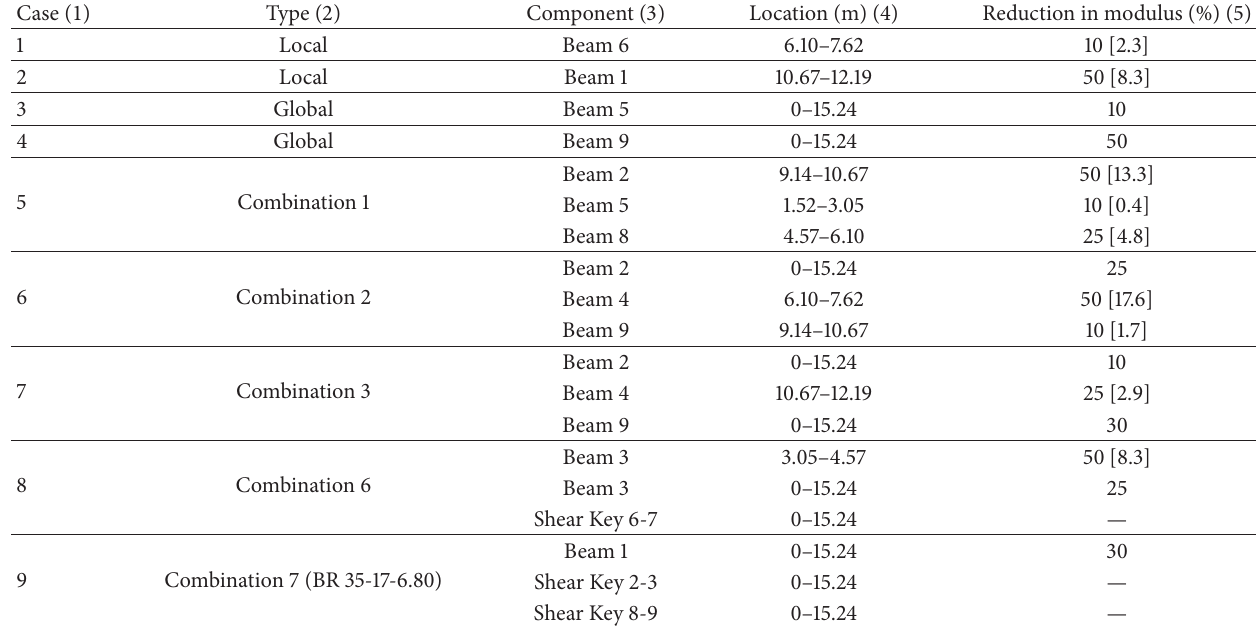
Table 1: Damage cases for evaluating CFTM method.